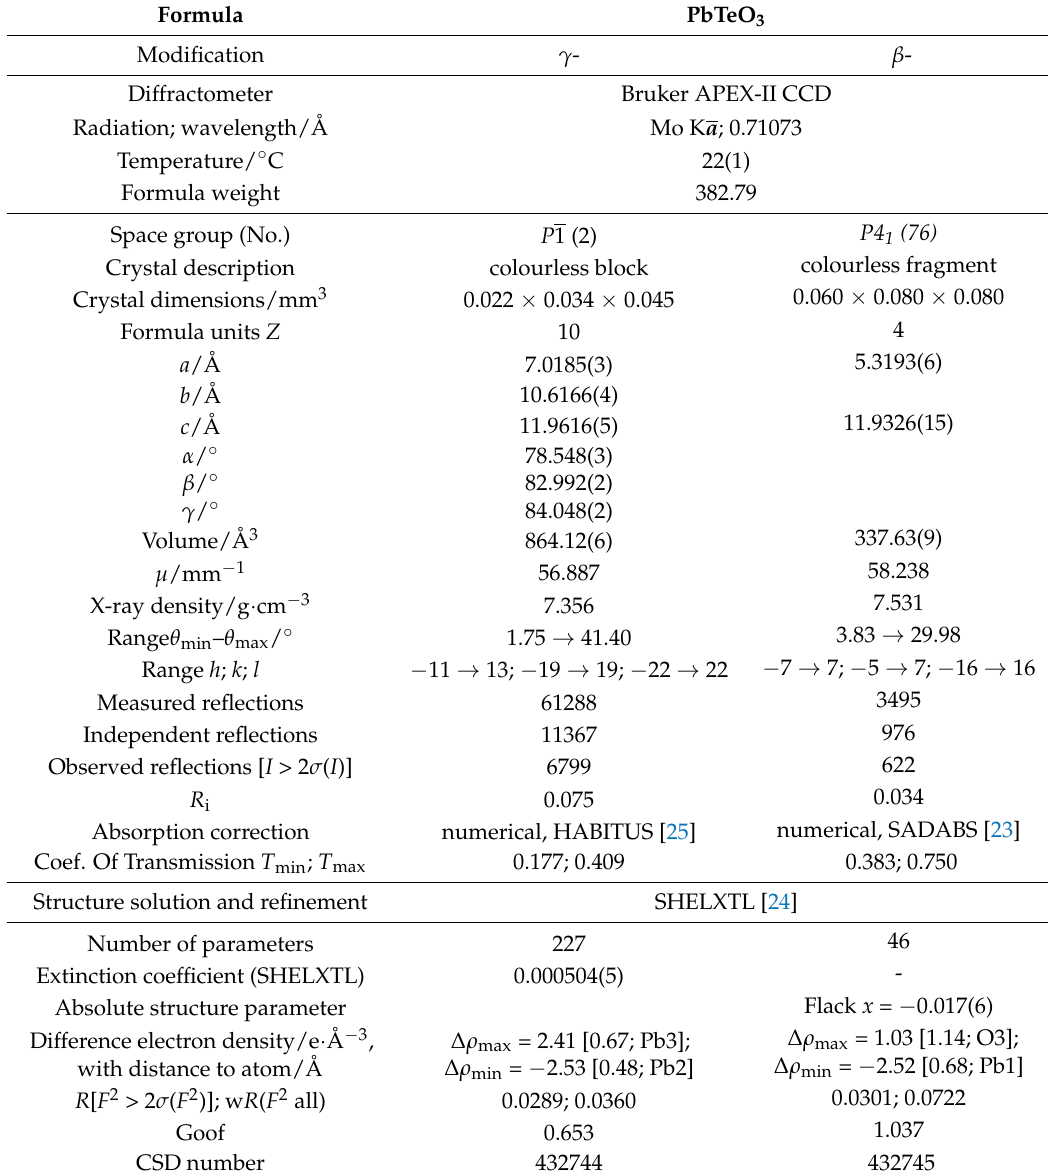
Table 1. Details of data collections, structure solutions, and